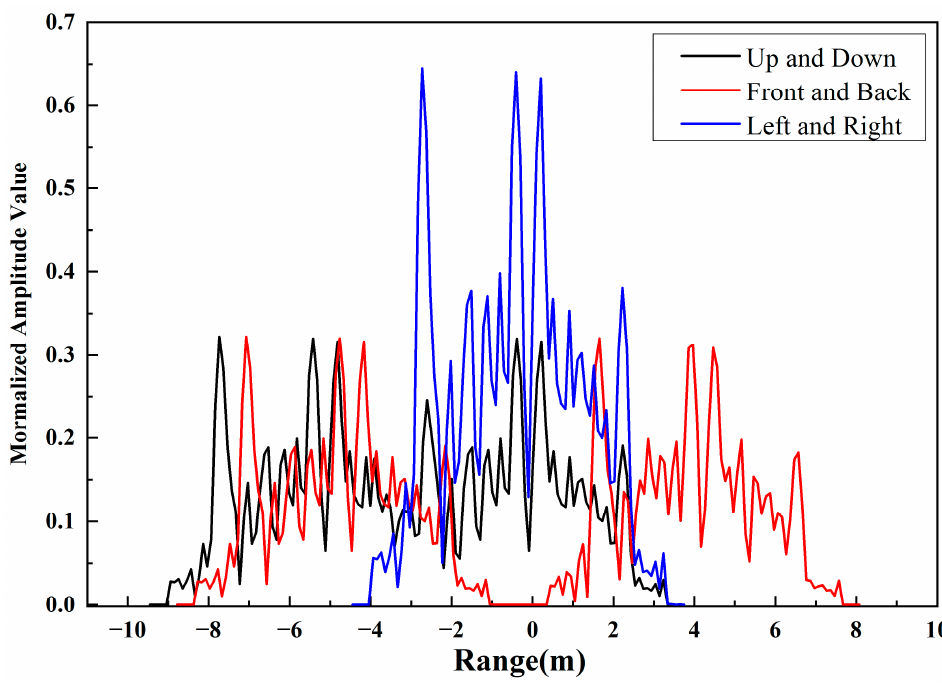
Figure 11. The HRRP of hybrid dielectric and conductor missile-like targets with different distribution of positions in free space.